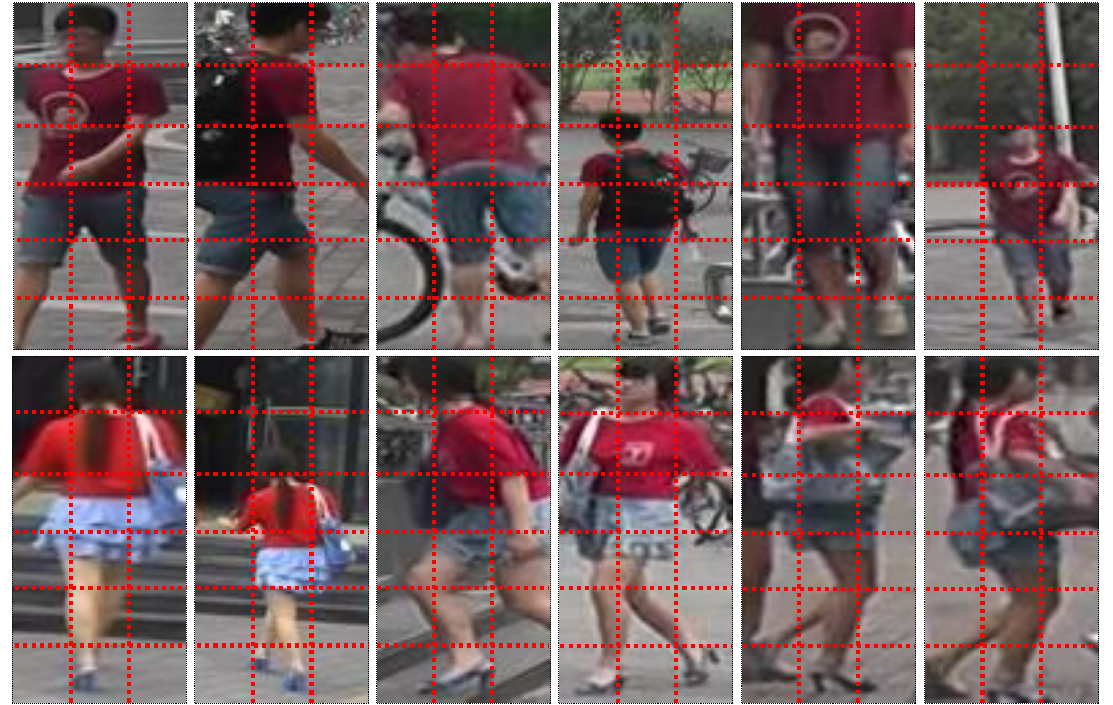
Figure 1. Examples of mis-aligned pedestrian images in Market-1501 dataset caused by pose variations and detection errors. The corresponding image patches of same identity are semantically unmatched (e.g., human head to